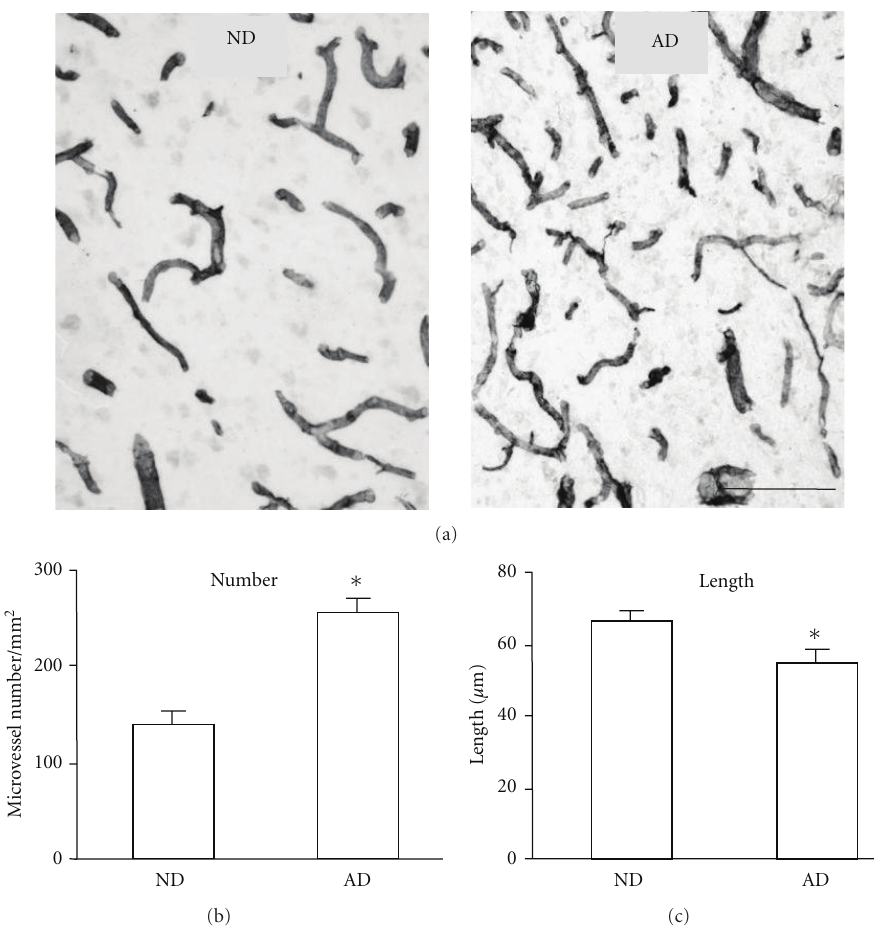
Figure 4: Representative laminin staining for microvessels in human ND and AD brain tissue. (a) Microvessels in ND (left panel) and AD (right panel). The scale bar represents 100 μ m. (b) Bar graph for mean numbers of microvessels/mm 2 . (c) Bar graph for microvessel length ( μ m) (ND, n = 9; AD; n = 9); ∗ P ≤ 0 . 05 for AD versus